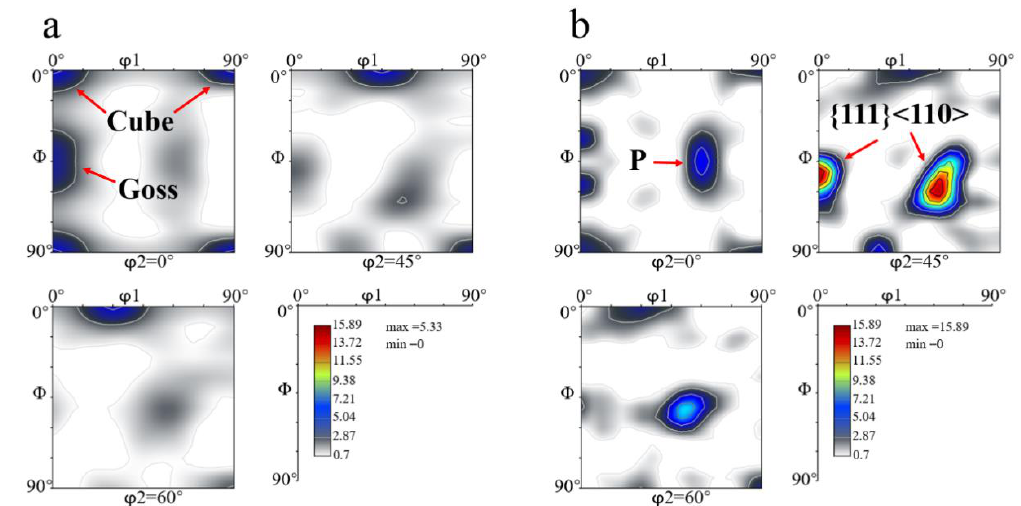
Figure 11. ODF maps (0°, 45° and 60°) of samples after solution treatment ( a ) FH, ( b ) SH.